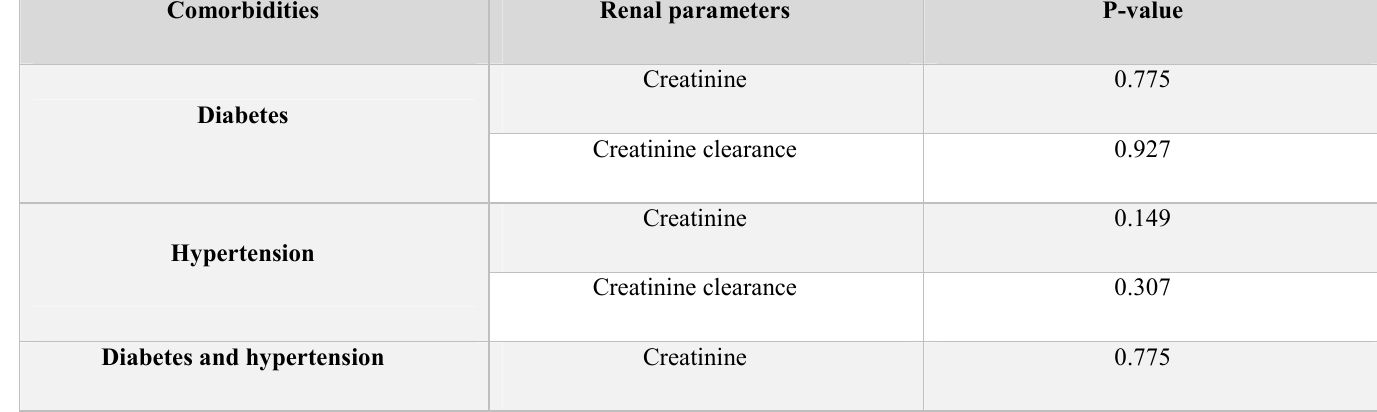
Table 6. Postoperative renal function grading